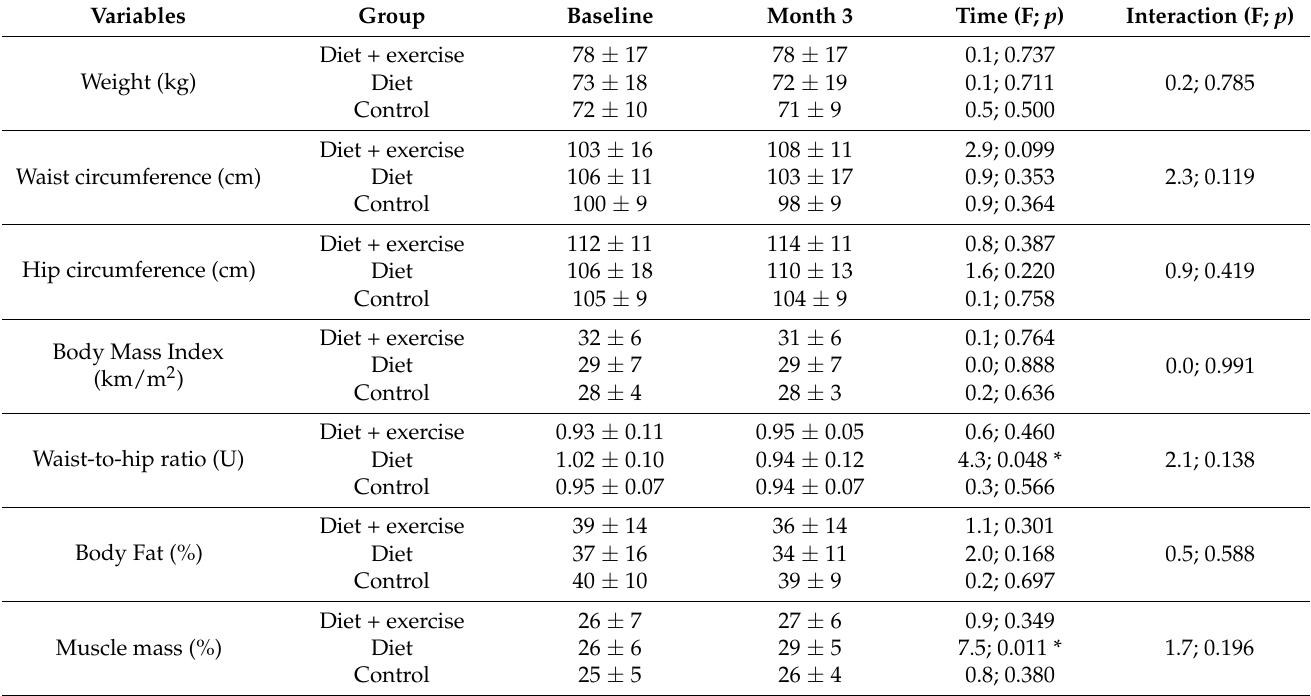
Table 2. Body composition measures per assessment, per group.